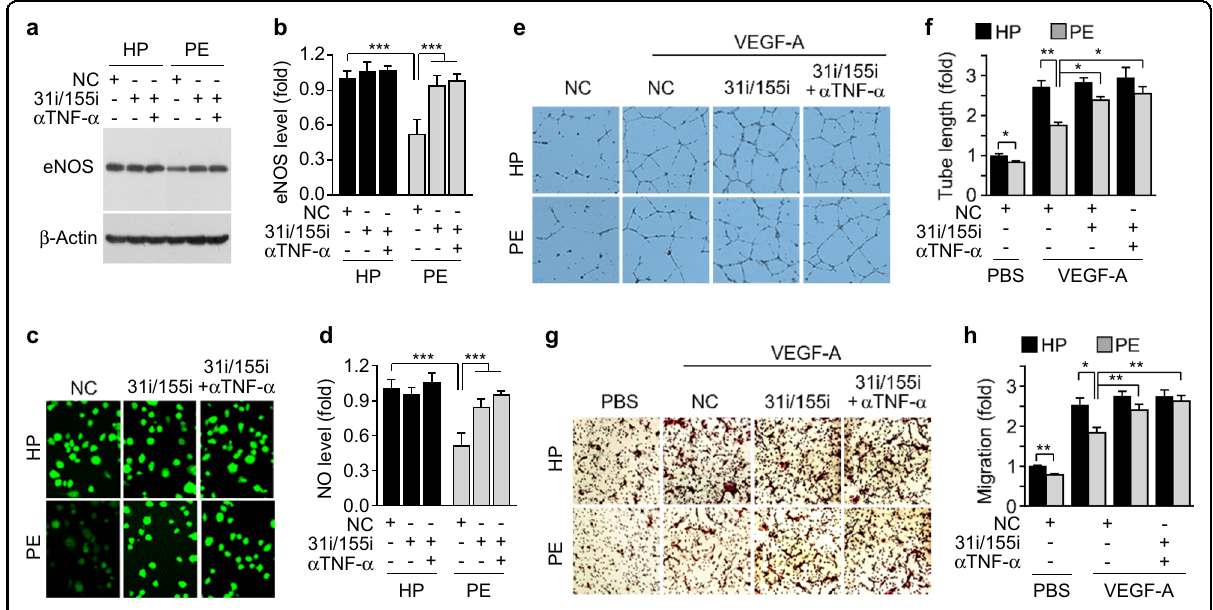
Fig. 3 Patient autologous serum suppresses eNOS and EPC functions. Adherent PBMNCs from healthy pregnant (HP) and preeclamptic women (PE) were transfected with miRNA inhibitor negative control (NC) or miR-31/155 inhibitors (31i/155i) and differentiated into EPCs in autologous serum-supplemented culture media in the presence or absence of a human TNF- α -neutralizing antibody ( α TNF- α ). a , b The expression levels of eNOS were analyzed by western blotting and quantitated using ImageJ. c , d Intracellular NO levels were analyzed by confocal microscopy and quantitated by ImageJ software. e , f EPCs were stimulated with VEGF-A on growth factor-reduced Matrigel, and tube formation was photographed using an inverted microscope and quantitated using ImageJ software. g , h EPC migration in response to VEGF-A was determined by the Boyden chamber assay and quantitated using ImageJ software. n = 4. * P < 0.05, ** P < 0.01, and *** P <